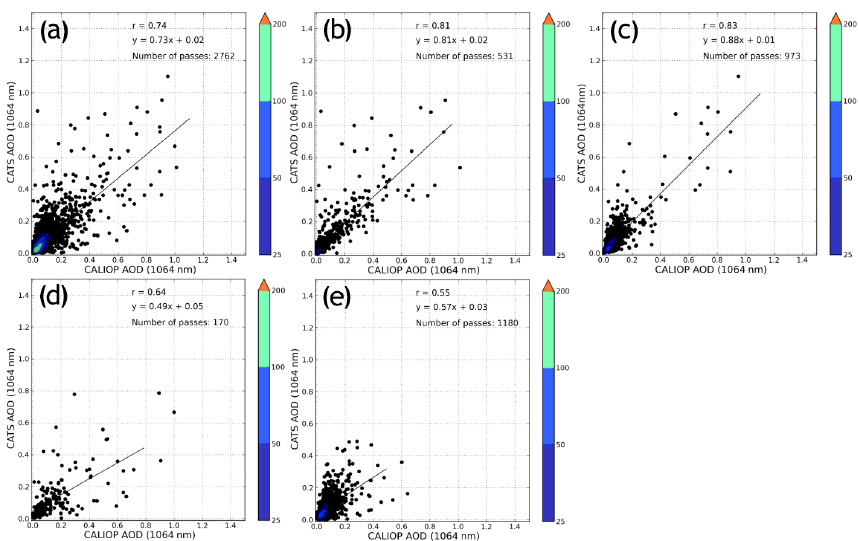
Figure 3. Collocated CALIOP 1064nm AOD vs. CATS 1064nm AOD with CATS QA applied for (a) both day and night, (b) nighttime over land, (c) nighttime over water, (d) daytime over land and (e) daytime over water. Table 1. Descriptive statistical properties between collocated CATS and AERONET, CALIOP and MODIS AOD retrievals. Here, SD indi- cates standard deviation of AOD and R value represents the correlation coefficient.